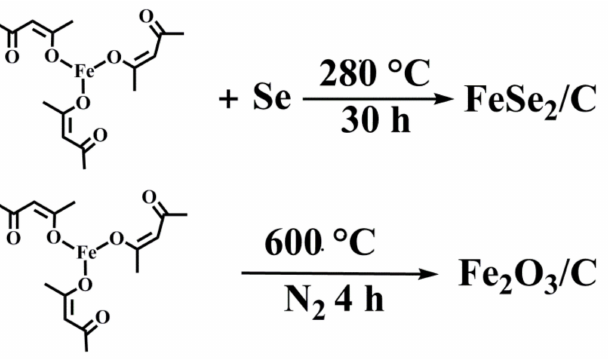
Figure 1. Schematic illustration for the preparation of FeSe2@C and Fe2O3@C